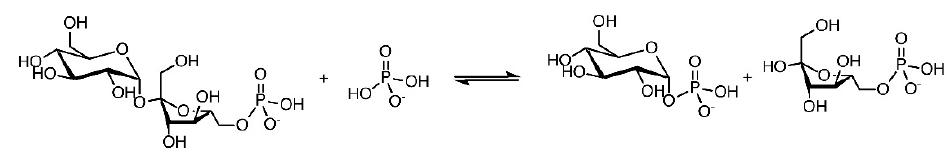
Figure 2. Reaction catalyzed by sucrose 6 F -phosphate phosphorylase.